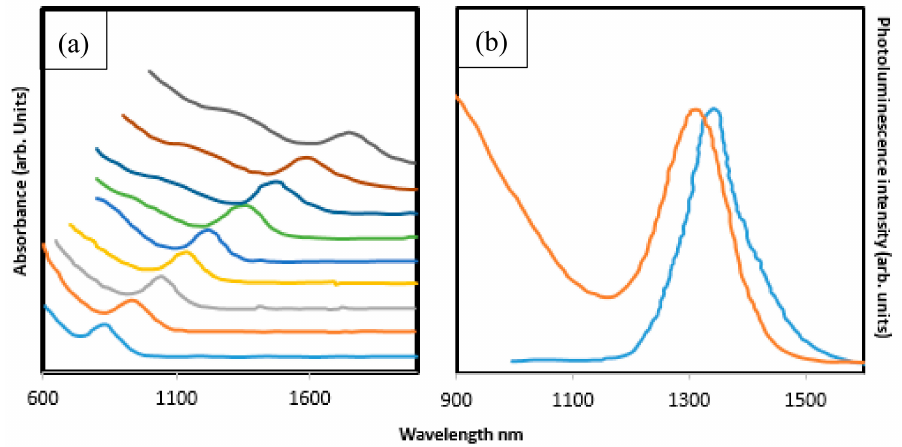
Figure 4. UV and PL absorption properties of PbS nanocrystals ( a , b ) (reproduced from ref. [48] with permission from the American Chemical